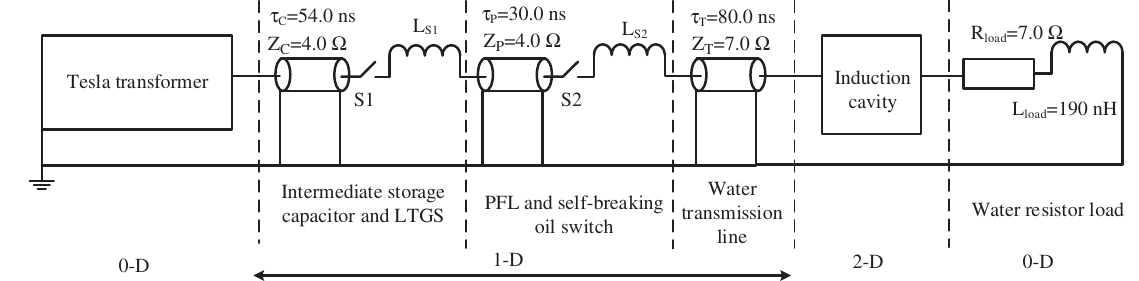
FIG. 10. Block diagram of the circuit model including the tesla transformer, intermediate storage capacitor, LTGS, PFL, self-breaking oil switch, water transmission line, induction cell, and water resistor load. τ C and Z C refer to the one-way transit time and impedance of the intermediate storage capacitor, respectively. S1 represents the LTGS and L S 1 indicates its inductance. τ P and Z P are the one-way transit time and impedance of the PFL, respectively. S2 represents the self-breaking oil switch and L S 2 indicates its inductance. τ T and Z T are the one-way transit time and impedance of the water transmission line, respectively. R inductance of the water resistor load, respectively.